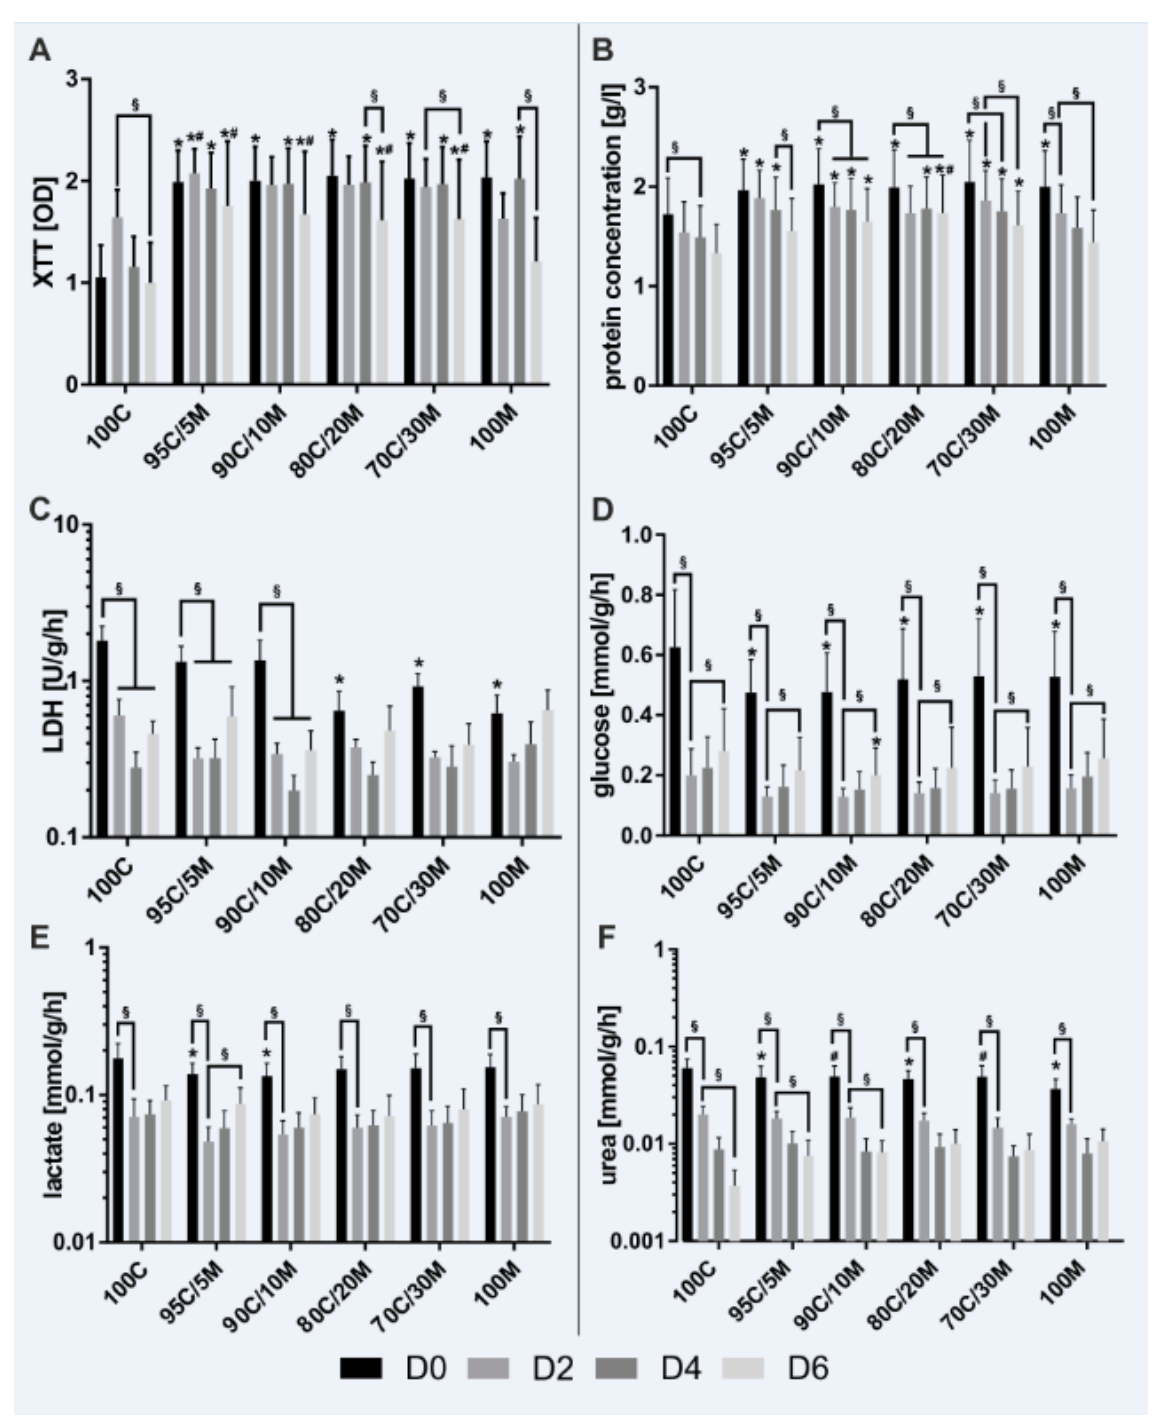
Figure 1: Metabolic activity of primary human hepatocytes (PHHs) in monolayer cultures (MCs) on different extracellular matrices (ECMs). PHHs were cultured for up to 6 days on pure collagen type I (100C), on ECMs based on collagen type I (C), supplemented with ascending percentages of Matrigel (M): 95C/5M, 90C/10M, 80C/20M, 70C/30M or on pure Matrigel (100M). PHHs were investigated for ( A ) metabolic activity determined by the conversion of XTT (2,3-bis-(2-methoxy-4-nitro-5-sulfophenyl)-2H- tetrazolium-5-carboxanilid); ( B ) protein concentration measured with the BCA (bicinchoninic acid) as- say; ( C ) enzyme activity of LDH (lactate dehydrogenase) and the production of ( D ) glucose, ( E ) lactate and ( F ) urea. LDH, glucose, lactate and urea were measured in cell culture supernatants and normalized to the protein concentration and duration of cell culture until supernatant collection. Data are shown